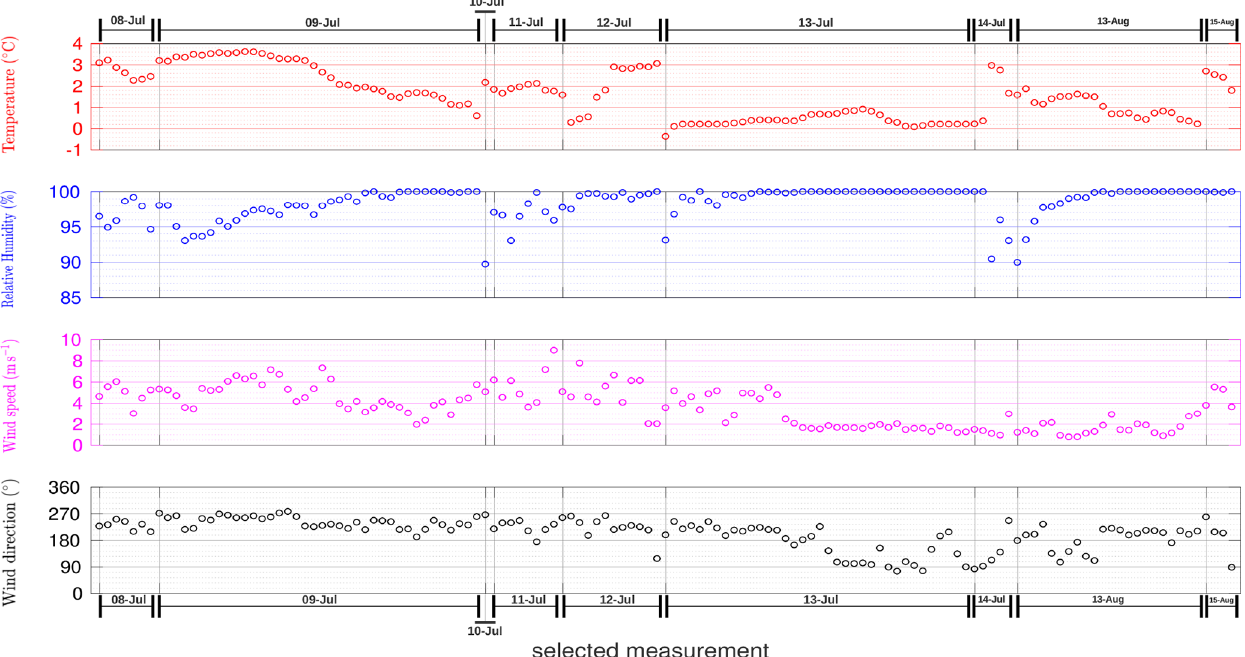
Figure 4. Local weather conditions at the UFS, obtained from recordings by the DWD during the measurement campaign including temper- ature, relative humidity, wind speed and wind direction. Each single point in the plots represents a mean of the DWD data collected during a selected measurement case (over a 15min interval). The selected cases on each day are shown in chronological order from left to right. However, two adjacent points do not necessarily represent two consecutive measurements due to the selection process. The wind direction is measured relative to a northerly orientation, with easterly, southerly, and westerly winds assigned 90 ◦ , 180 ◦ , and 270 ◦ angles, respectively. Table 3. Comparison between the cloud droplet measurement data from the VisiSize and PDI probe collected on 13 July 2019 at 15:36 and 15:51CET.